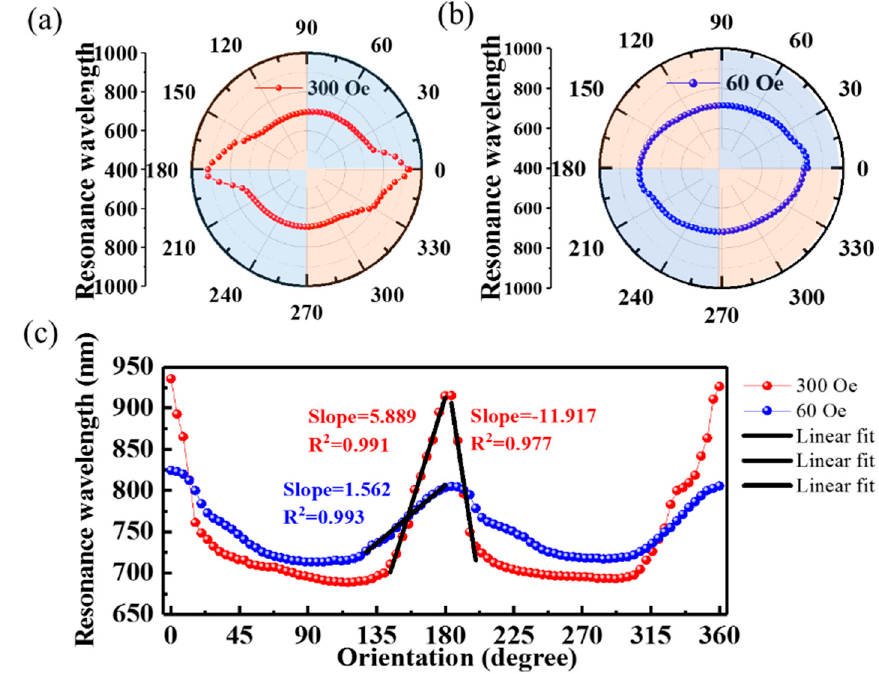
Figure 8. Resonance wavelength as a function of magnetic-field orientation plotted in ( a , b ) polar coordinates and ( c ) Cartesian coordinates. The magnetic field intensity is fixed at 300 Oe (red dots) and 60 Oe (blue dots).